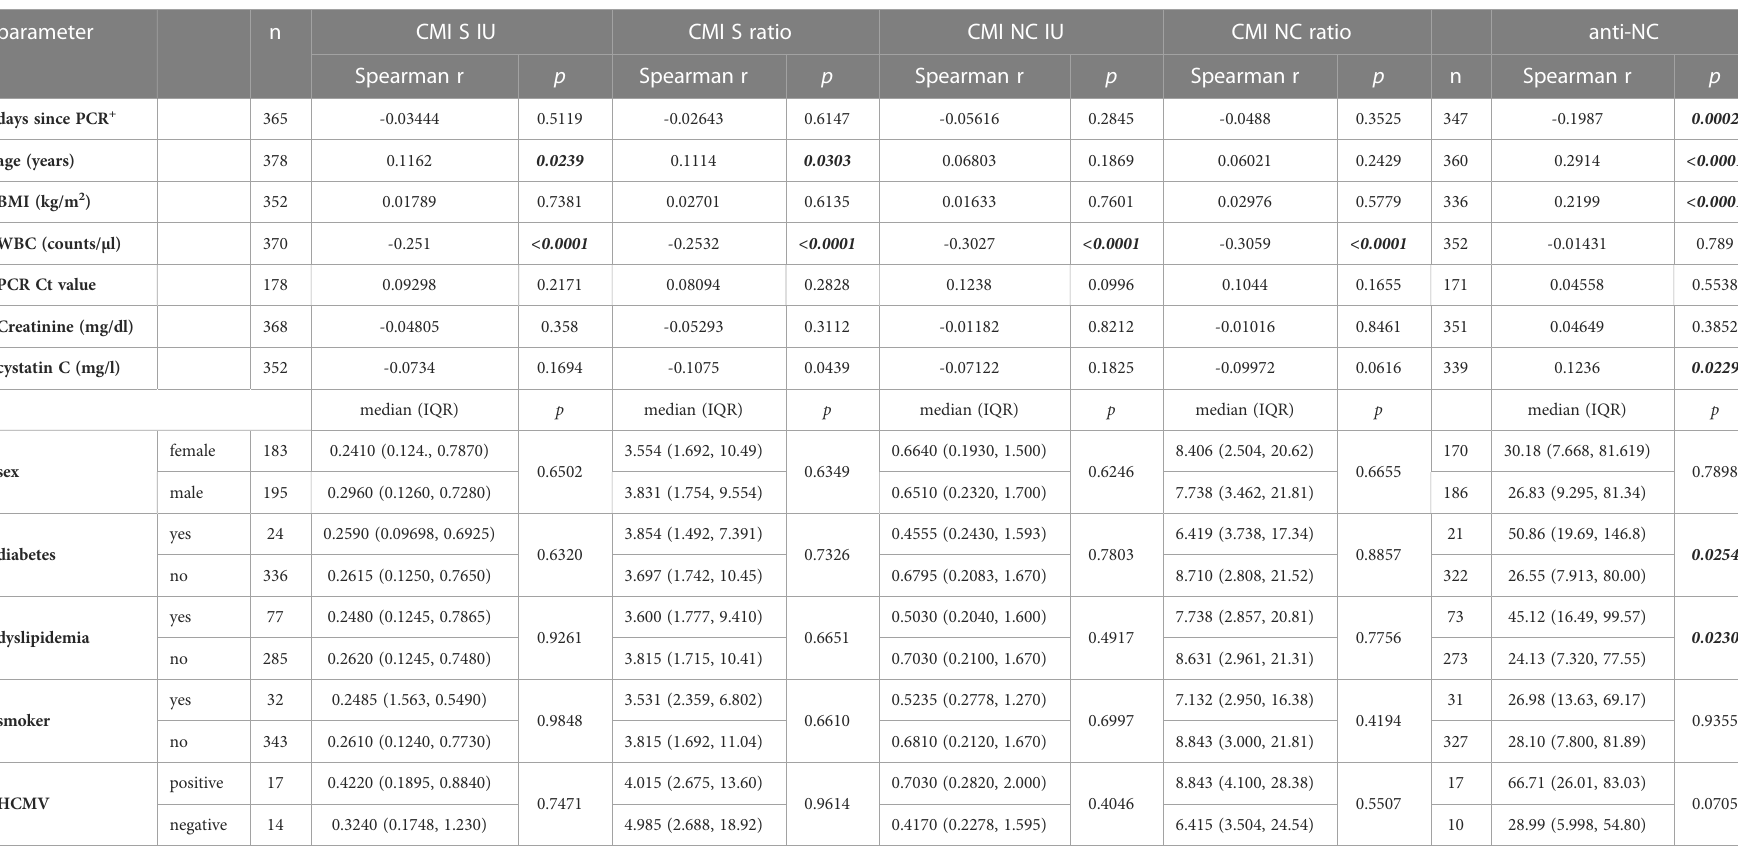
TABLE 1 Summary of potential confounders for anti-SARS-CoV-2 CMI and antibody testing (A) Correlation or direct comparison of cohort characteristics and additional laboratory parameters to measurements of SARS-CoV-2 CMI and antibody testing.